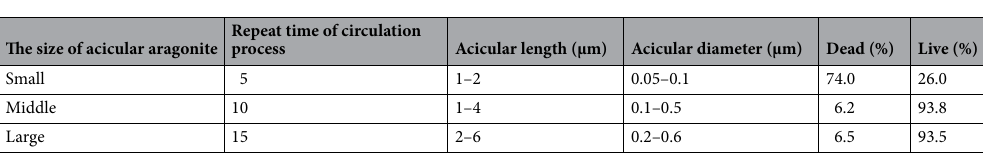
Table 1. The morphological characteristics of acicular aragonite and its L/D performance.